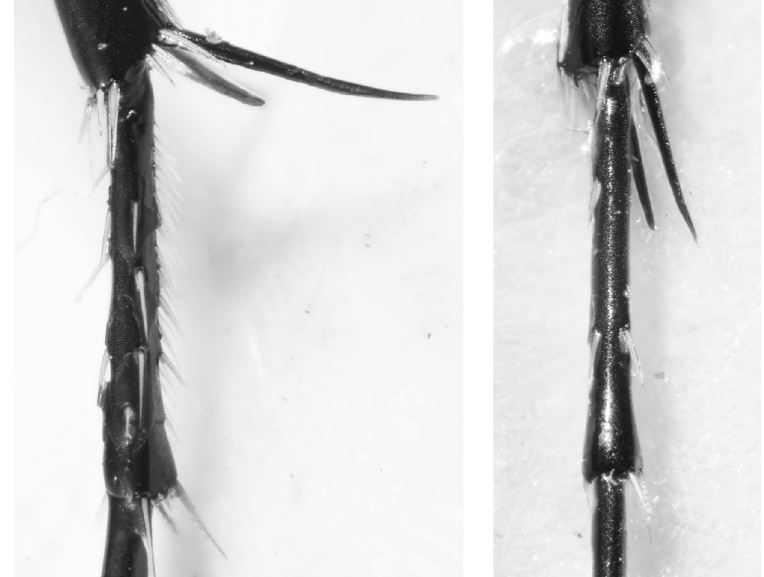
Figure 53. Tibial spurs and 1 st tarsal segment of Calomera littoralis winkleri (left) and Calomera aulicoides